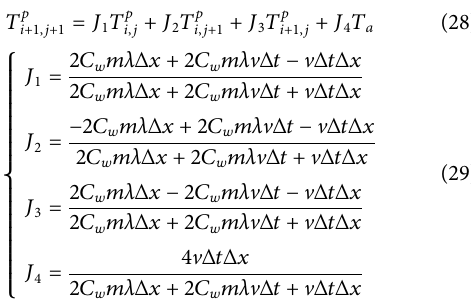
FIGURE 3 Illustration of FDM for thermal